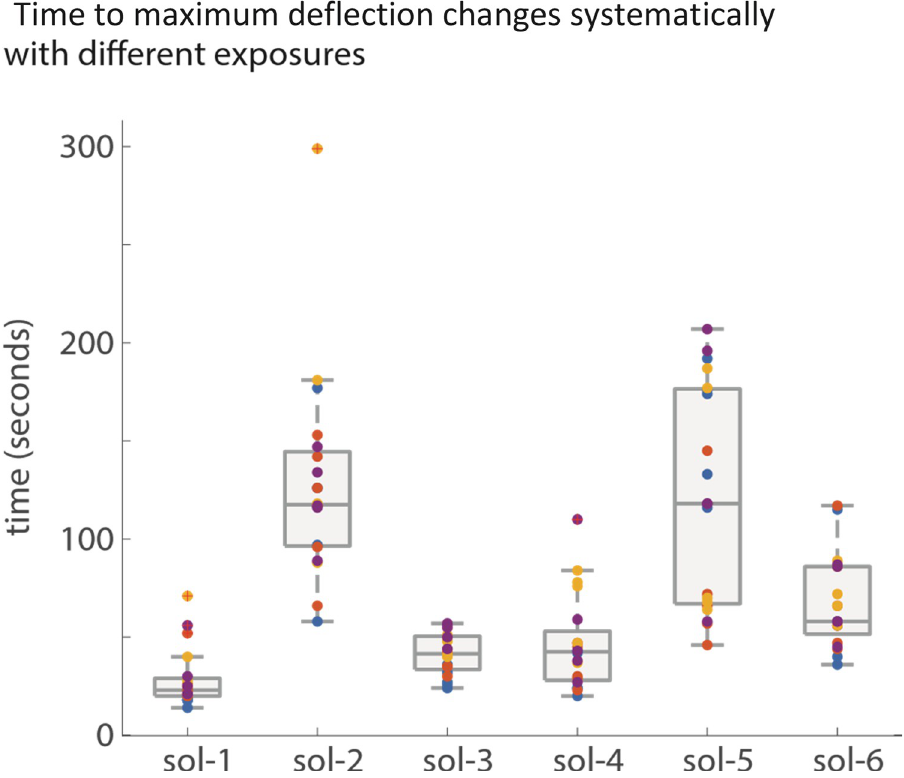
Fig 6. Speed of deflection. The time to maximum deflection changes systematically between exposures to the different acetone and ethanol concentrations but there is a large range in the responses.